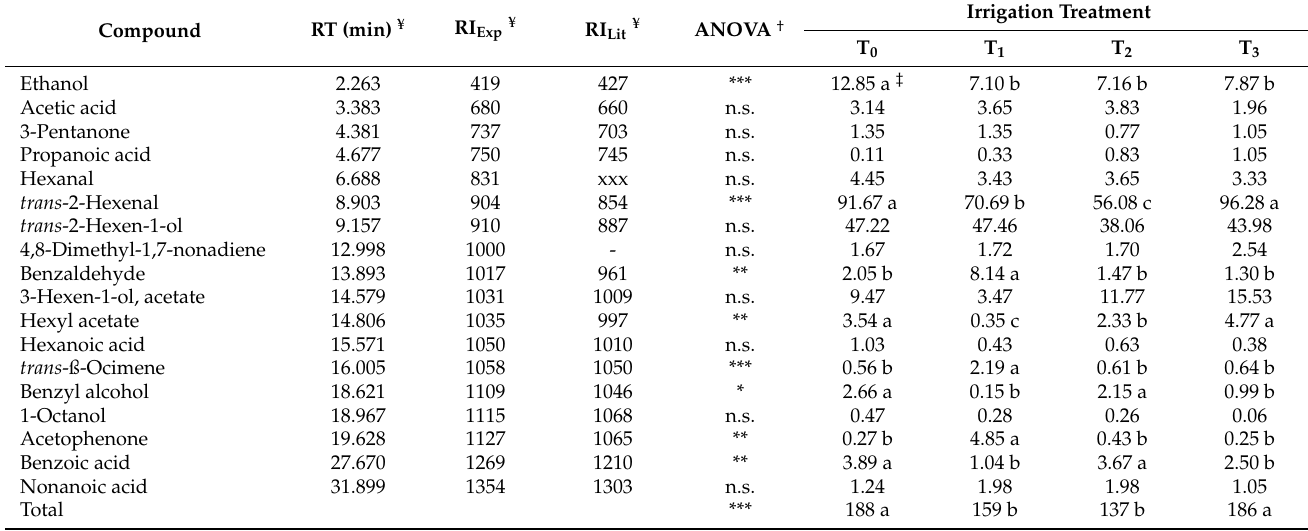
Table 5. Volatile composition (mg 100 g − 1 olive oil) of ‘Arbequina’ olive oil samples obtained from a super-high-density olive tree orchard. Data are the mean of two seasons, 2018 and 2019. Compound